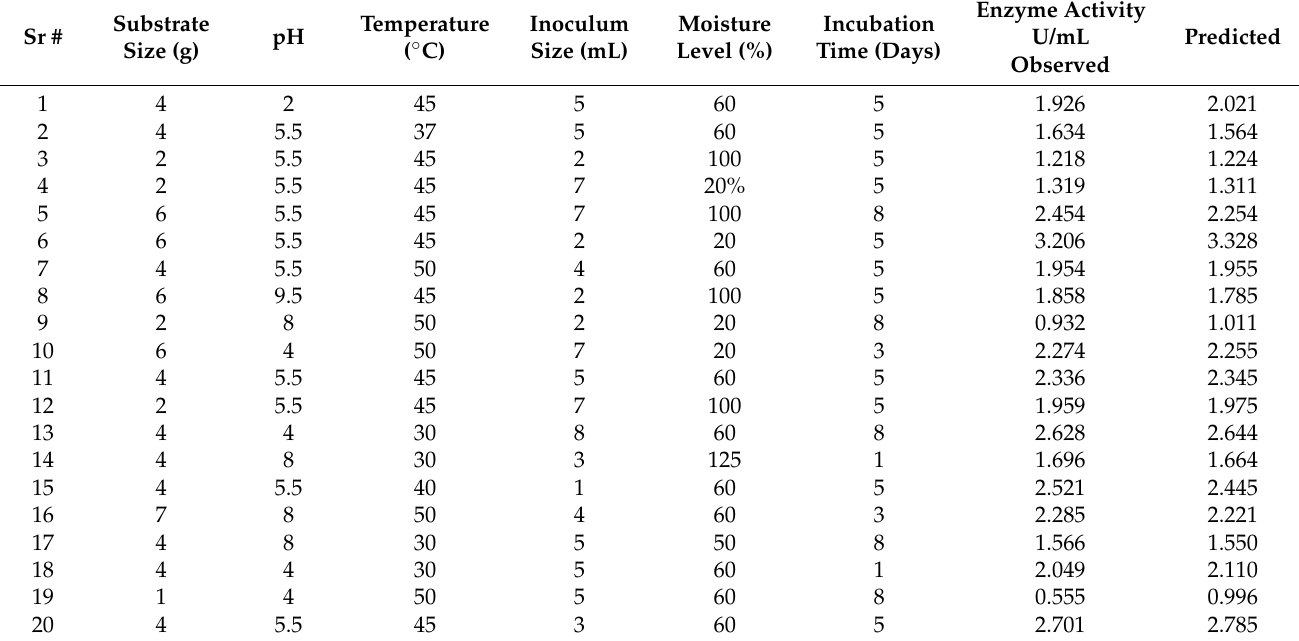
Table 2. Optimization via RSM